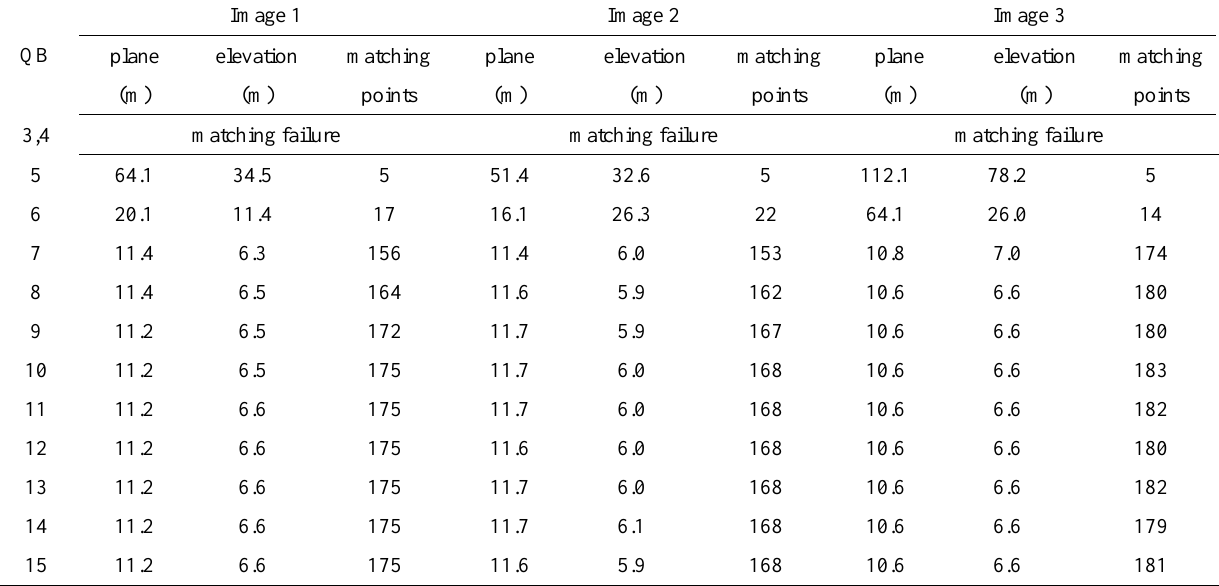
Table 3. the plane error, elevation error and number of matching points with different